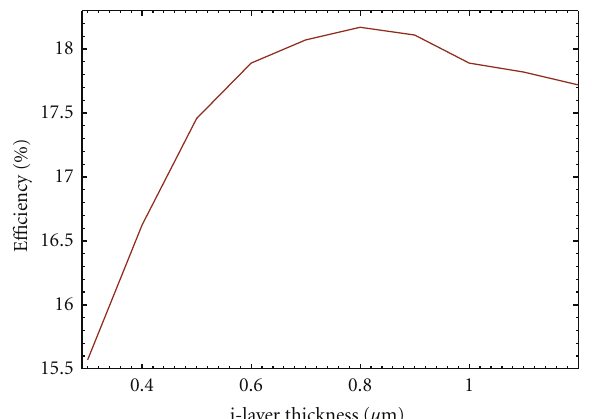
Figure 10: The a-SiGe:H solar cell e ffi ciency as a function of i-layer thickness.